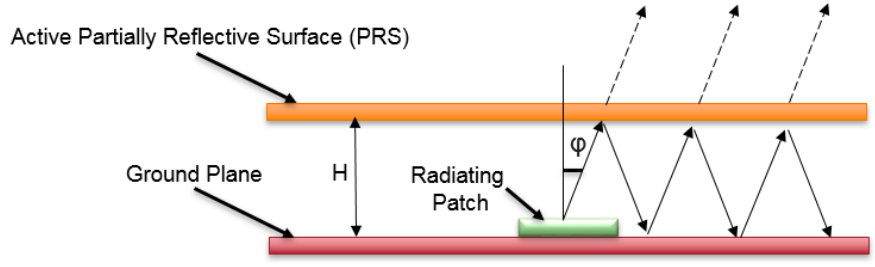
Figure 1. The active PRS structure conceptual diagram.